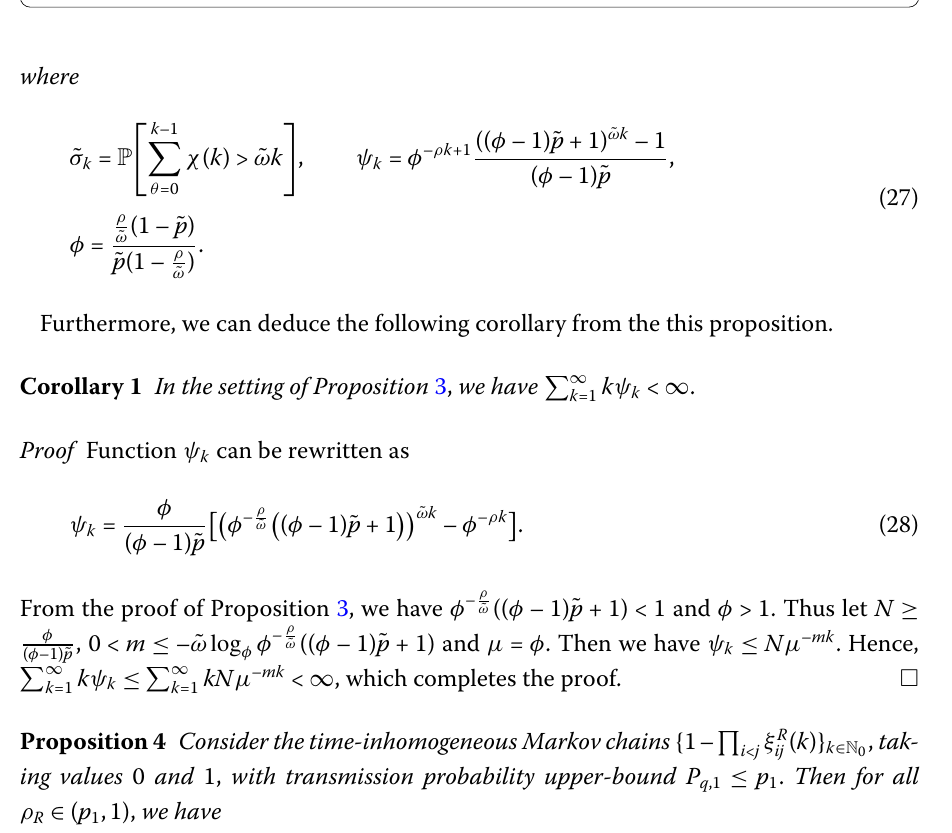
Figure 13 The norms of position and velocity trajectories with α = 1.2 in Case